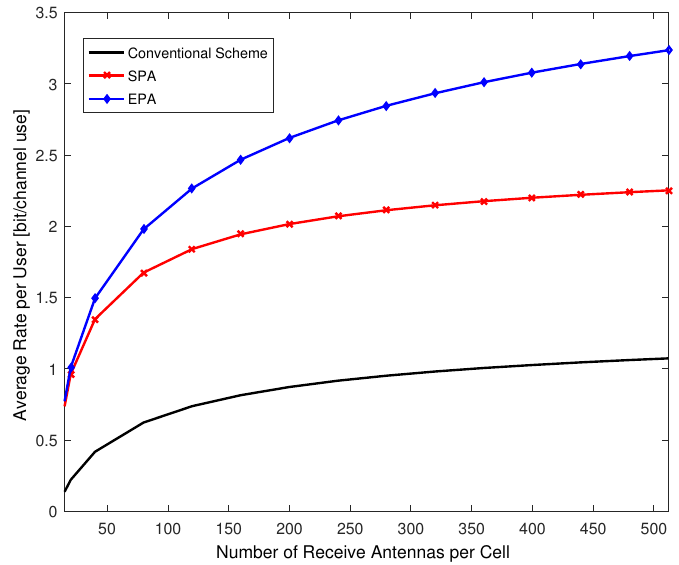
Figure 3. The average uplink rate per user with zero forcing (ZF) for different numbers of